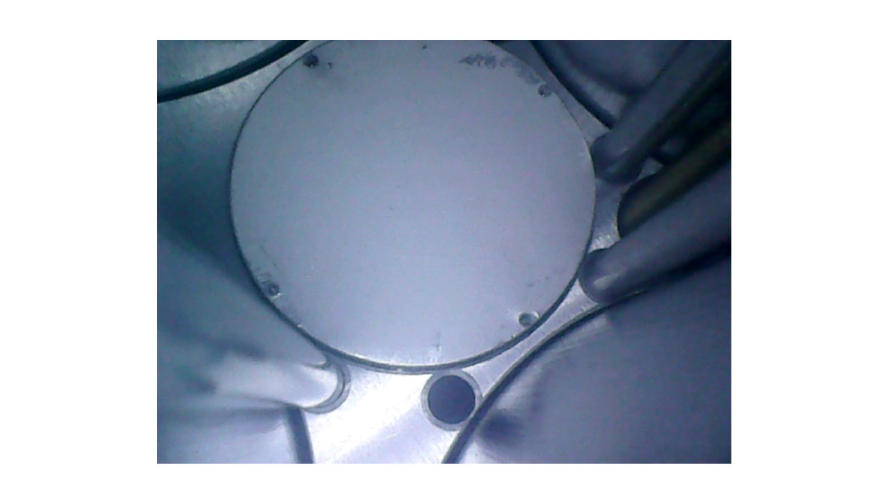
Figure 3. Circular scintillating screen (23.8 mm diameter, total thickness about 2 µ m) illuminated by the LED of the endoscope camera. The perspective angle is corrected by the pre-processing software.